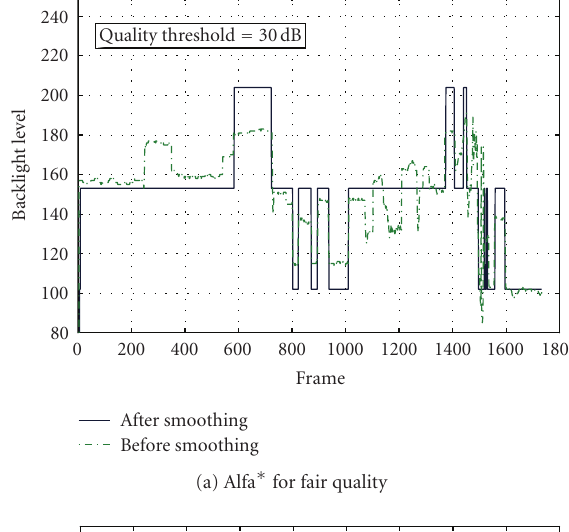
Table 1: Results of QABS (G: good; F: fair; E: Excellent).